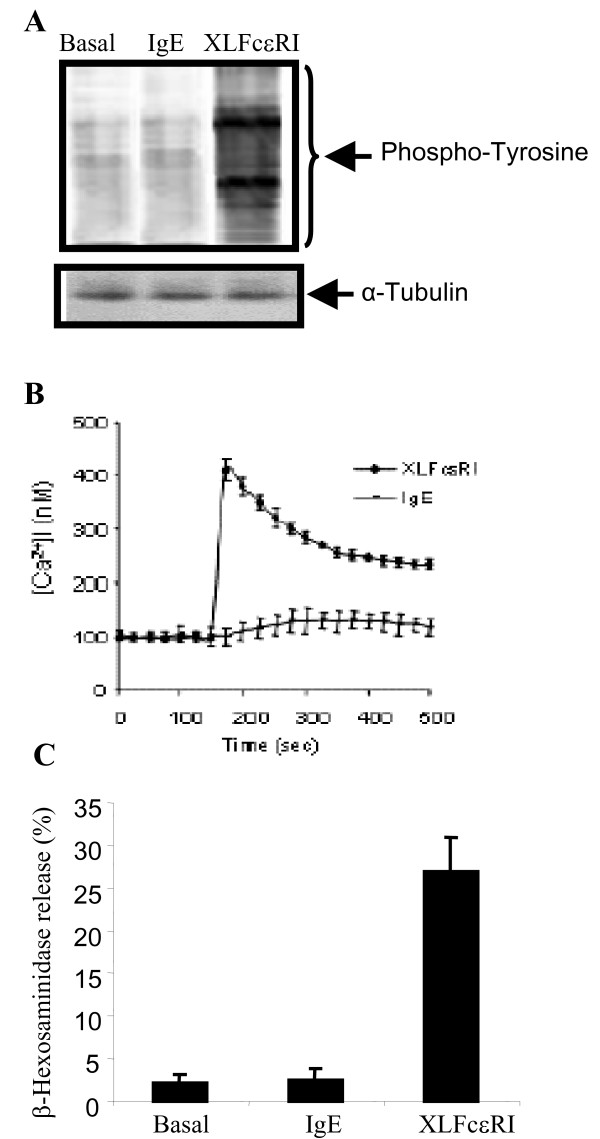
Mast cell activation: tyrosine phosphorylation, calcium signals, degranulation. A. Analysis of overall protein phosphorylation on tyrosine residues. Upper panel; overall tyrosine-phosphorylation pattern was analysed in cell extracts from: control unstimulated cells (Basal); cells treated with IgE alone for (IgE) for 5 min; and after FcεRI crosllinking for 5 min (XLFcεRI). Lower panel; the blots were probed for α-tubulin (control for equal loading). Results shown are representative of four separate experiments. B. Levels of intracellular free calcium. Intracellular calcium measurements of mast cells following addition of IgE alone (IgE); and following the addition of the anti-human IgE, to IgE-sensitized cells (XLFcεRI), the intracellular calcium levels were analyzed in a continuous reading for the timesstated in the graph. Results shown are the mean plus the standard deviation of triplicate measurements and are representative of four separate experiments. C. Degranulation. B-hexosaminidase release was determined from control-unstimulated mast cells (Basal); following monomeric-IgE-sensitization for 30 minutes (IgE); and following FcεRI aggregation by addition of the anti-human IgE to sensitized cells for 30 minutes (XLFcεRI). Results shown are the mean plus the standard deviation of triplicate measurements and are representative of four separate experiments.